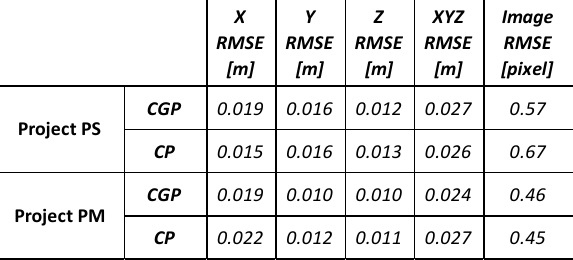
Table 7. Results of terrestrial image orientation using